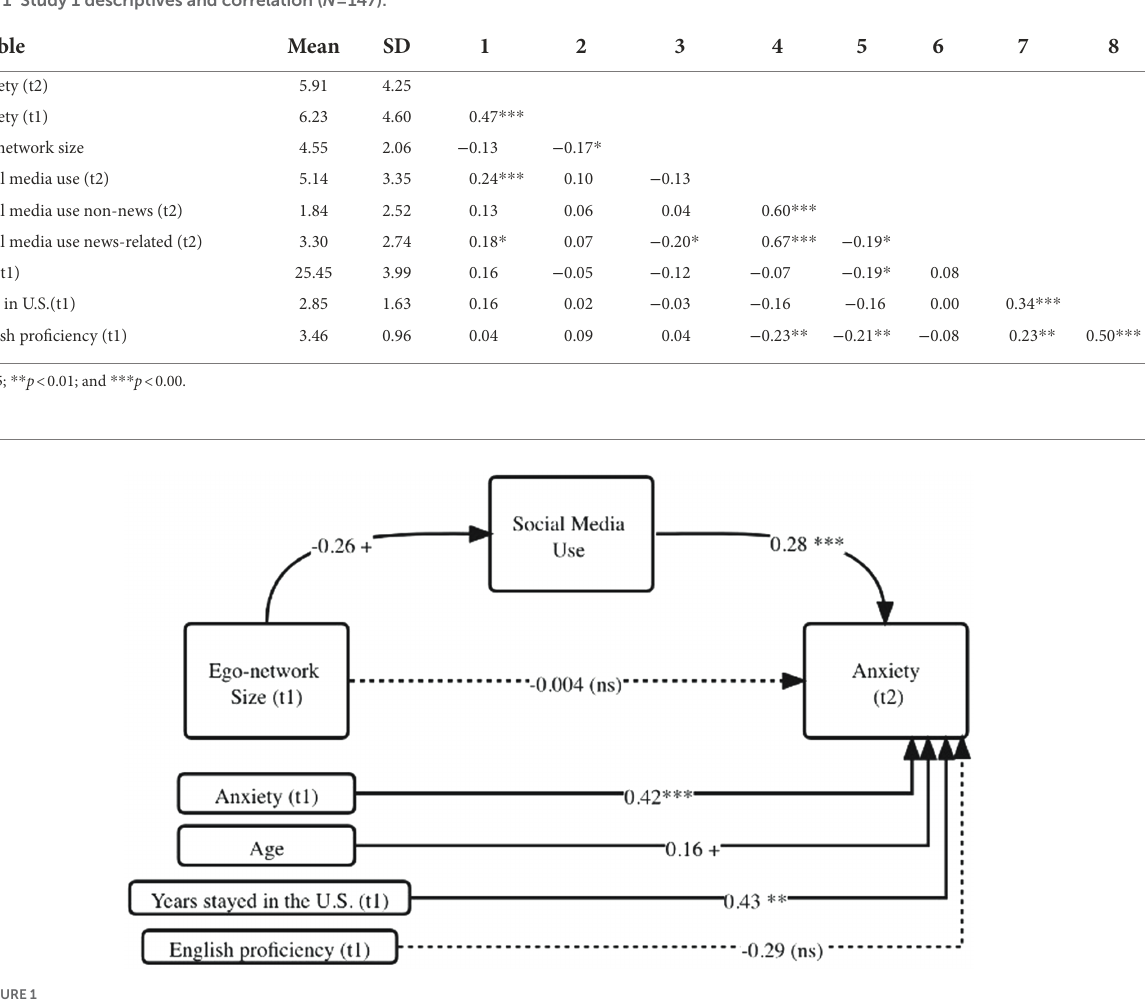
TABLE 1 Study 1 descriptives and correlation ( N = 147).